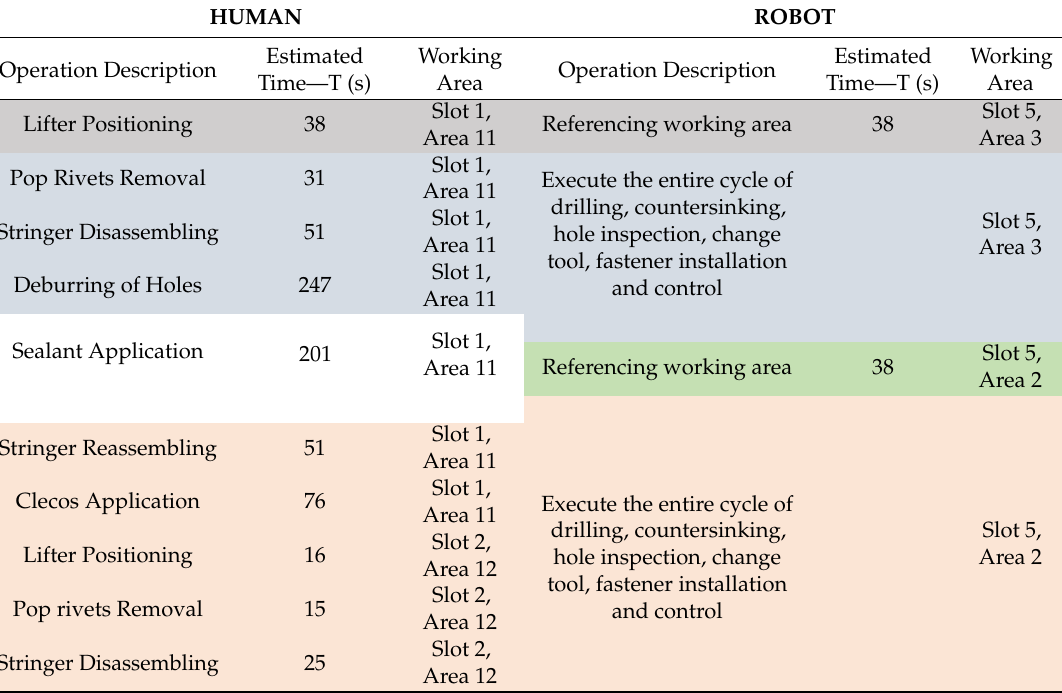
Table 3. Part of the working cycle in HRI configuration.